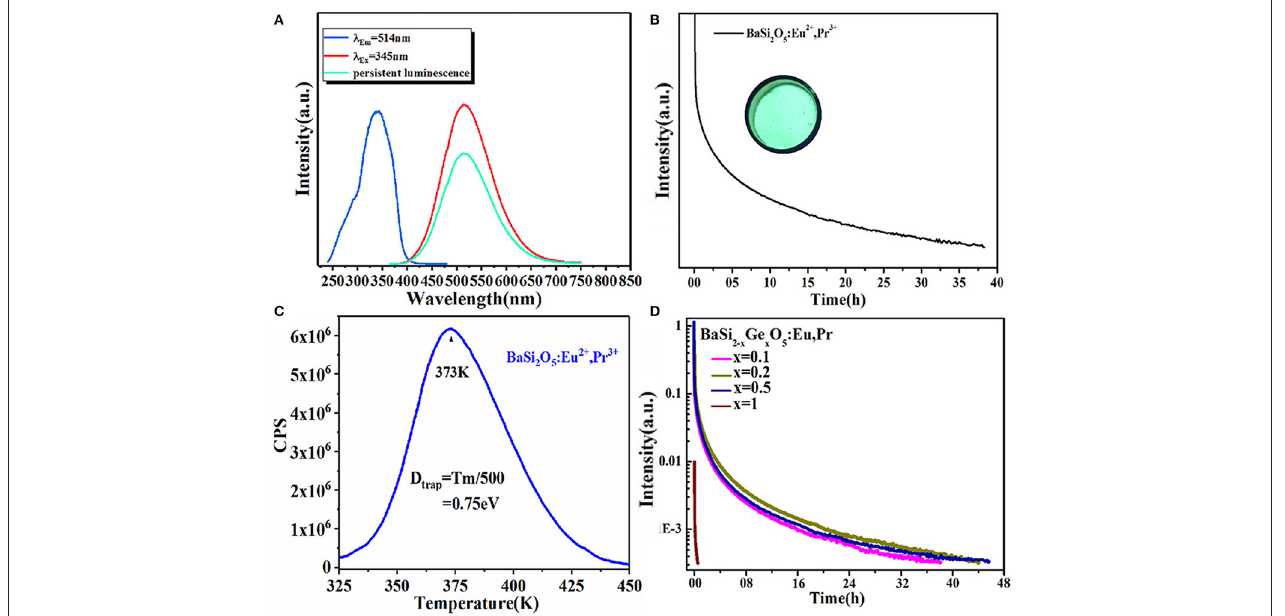
FIGURE 4 | (A) The PLE, PL and LPL spectra of BaSi 2 O 5 : 0.008Eu 2 + , 0.01Pr 3 + . (B) LPL decay curve of BaSi 2 O 5 : 0.008Eu 2 + , 0.01Pr 3 + . Inset: the digital photo under 254nm irradiation. (C) TL spectra of BaSi 2 O 5 : 0.008Eu 2 + , 0.01Pr 3 + . (D) LPL decay curves of BaSi 2 − x Ge x O 5 : 0.008Eu 2 + , 0.01Pr 3 + (0 ≤ x ≤ 1). Reprinted with permission from Feng et al. (2019). Copyright (2019) American Chemical